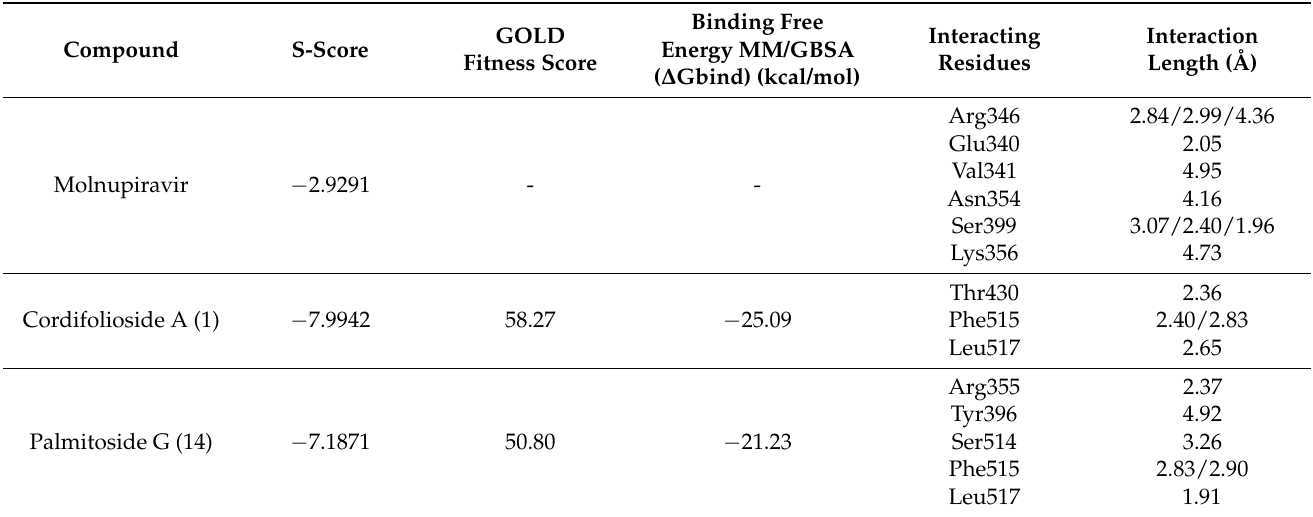
Table 2. MOE S-score, GOLD fitness score, binding free energy, and protein–ligand interactions of natural compounds with the SARS-CoV-2 S1-RBD region